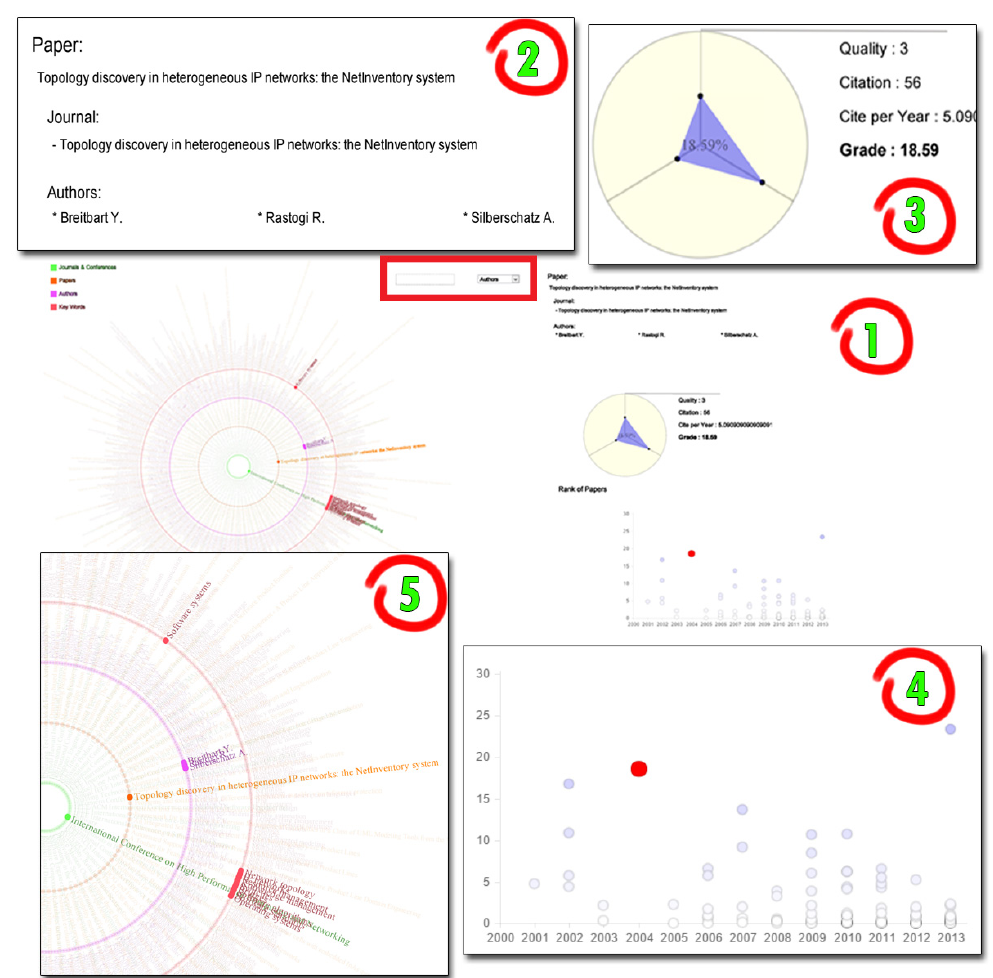
Figure 14. Screen shot of whole application and its